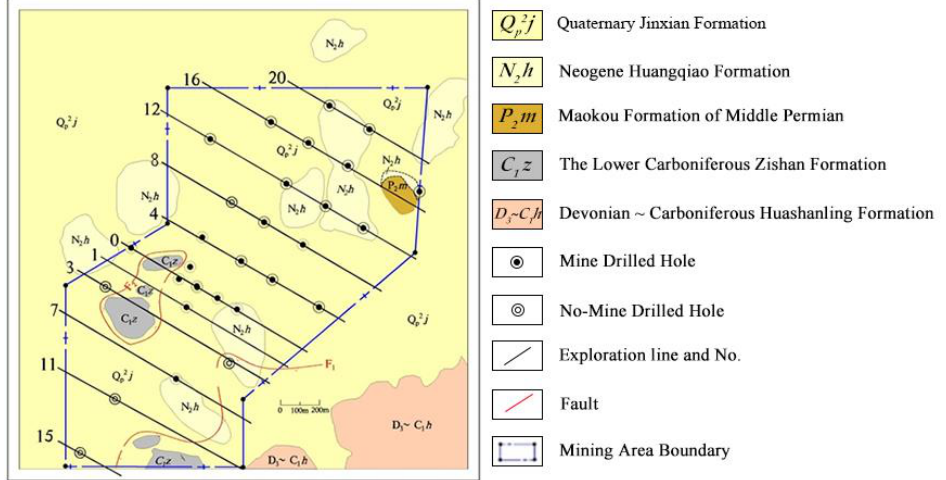
Figure 1. Geology map of Shilukeng deposit.